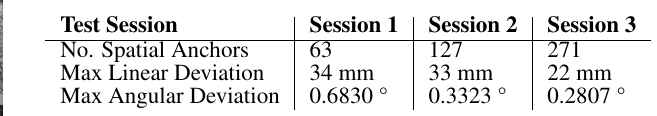
Table 1. Comparison of deviation across sessions using different amount of Spatial Anchors.